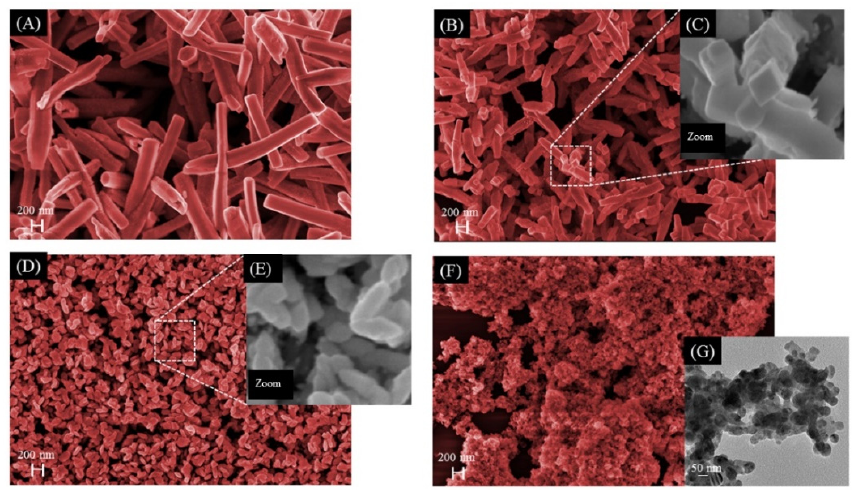
Figure 3. FE-SEM images of α -Ag 2 WO 4 ( A ), α -Ag 2 WO 4 -TA ( B ) (inset ( C ), images of the formation of rectangular morphology), α - Ag 2 WO 4 -BA ( D ) (inset ( E ), formation of nanometric rice-grains), and α -Ag 2 WO 4 -CA ( F ). TEM images for α -Ag 2 WO 4 -CA showing higher magnifications of the nanoparticles ( G ).